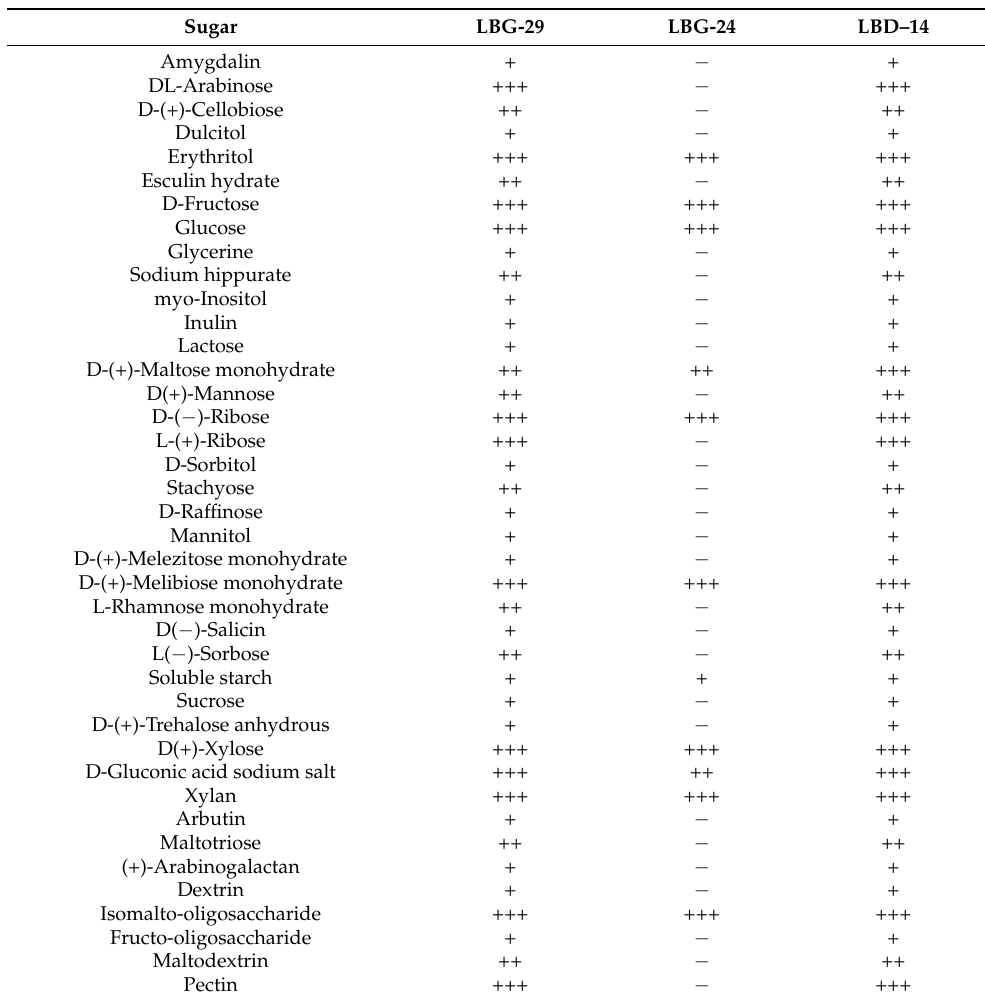
+, positive reaction; − , negative reaction. Table 3. Sugar